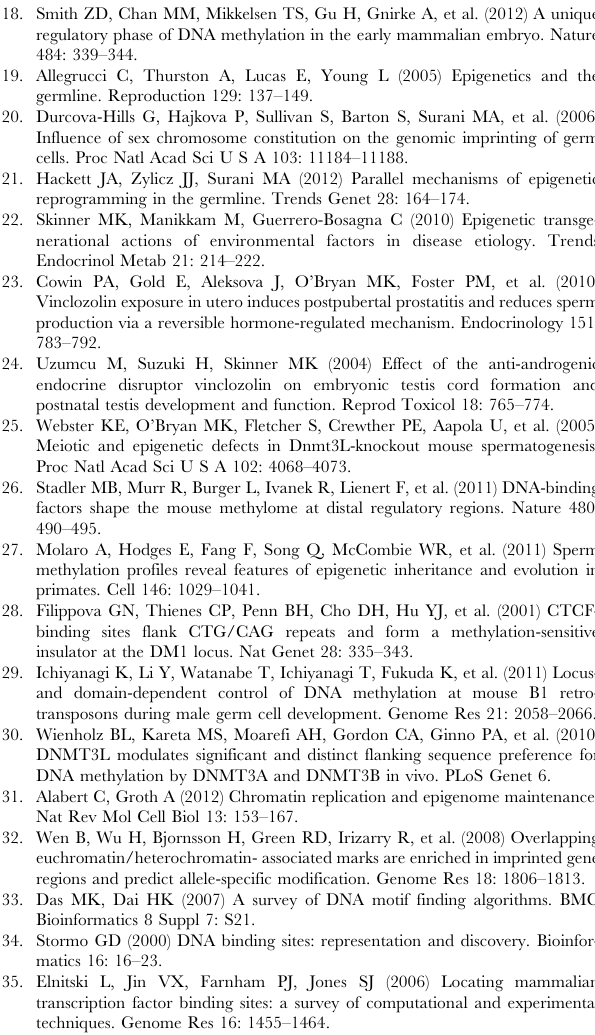
Incidences of motifs between the DMR from different treatments and random sets were tested with Fisher’s test. Comparison of density of motif incidences between treatment sets of DMR and random sets were performed with Student’s t-test. The average of the distributions of G quadruplexes and A/T strings was also compared with Student’s t-test between the treatment DMRs and random sets.